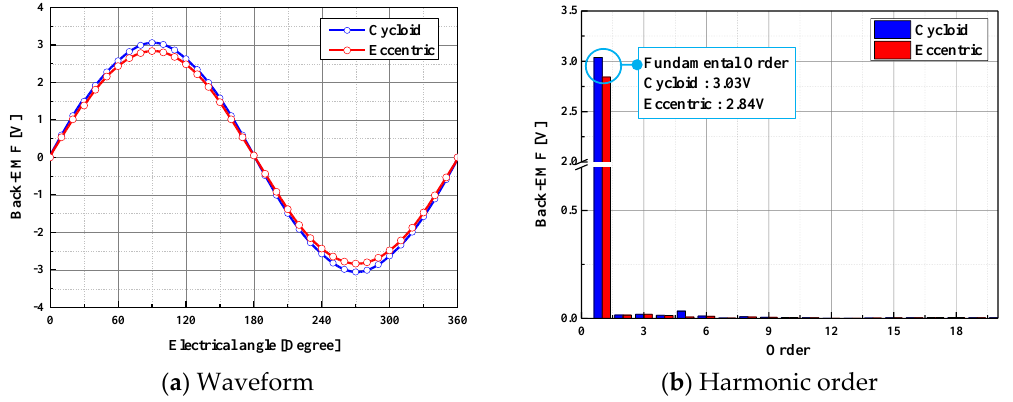
Figure 16. Back-EMF: ( a ) waveform; ( b ) harmonic order.